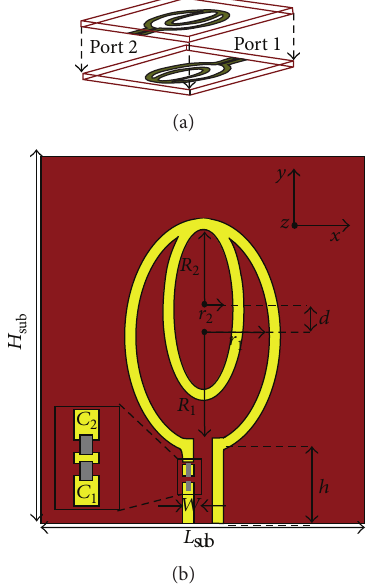
Figure 2: Geometry of the proposed wireless energy link: (a) perspective view; (b) front view. It can be seen that the secondary resonator is overlapped to the primary